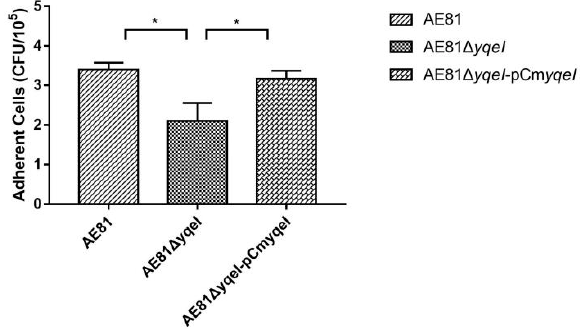
Figure 5. The cell adhesion number was calculated by plate counting. The cell number of AE81 Δ yqeI was significantly decreased compared with AE81. The cell numbers of AE81 and AE81 Δ yqeI -pCm yqeI were similar, * p < 0.05.